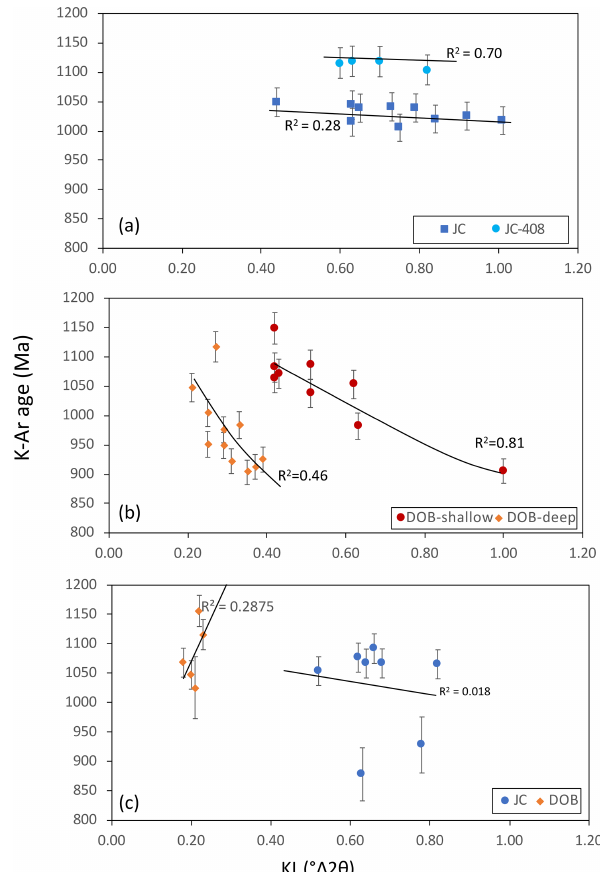
Figure 11. Correlations between K–Ar ages and KI values for fault gouge illites for samples from Dobbyn 2 (a) , Julia Creek 1 (b) , and matrix illites from sandstone host rocks (c) ( > 2µm fractions were not included). Analytical errors of K–Ar ages were disregarded for the regression lines. Exponential trends were obtained for the best fit of the regression lines for Dobbyn 2 samples (a) . Note the flat trends that are obvious for Julia Creek 1 samples for fault gouges (b) and matrix illites (c)